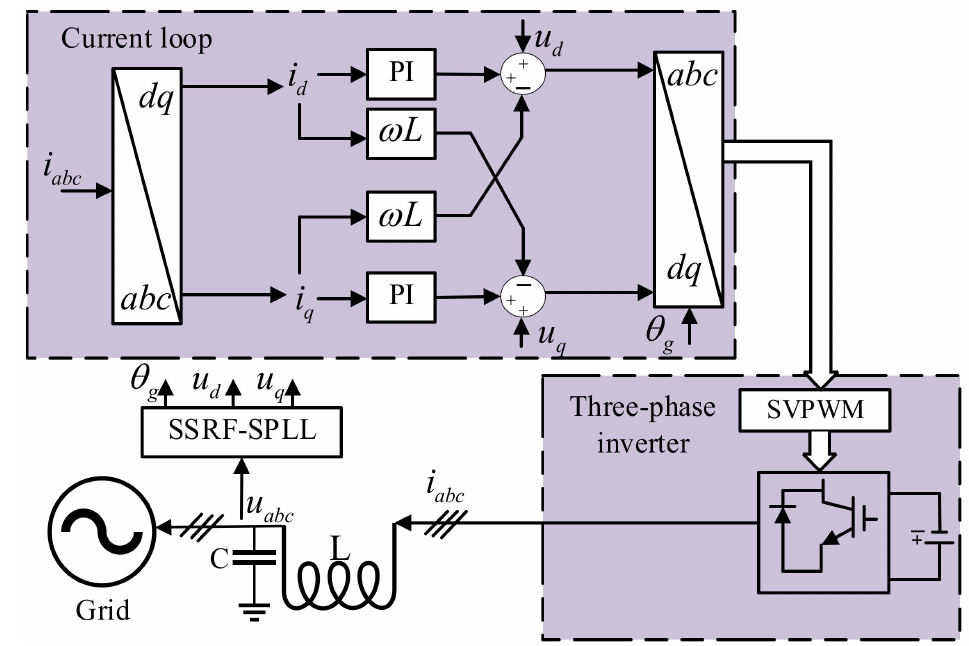
Figure 14. Simulation model for the microgrid grid-connected system.